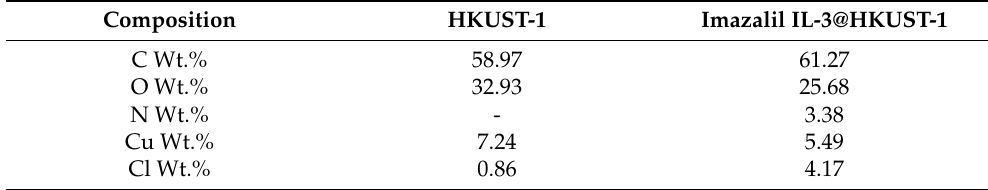
Table 1. Surface composition of HKUST-1 and imazalil IL-3@HKUST-1 determined by XPS.